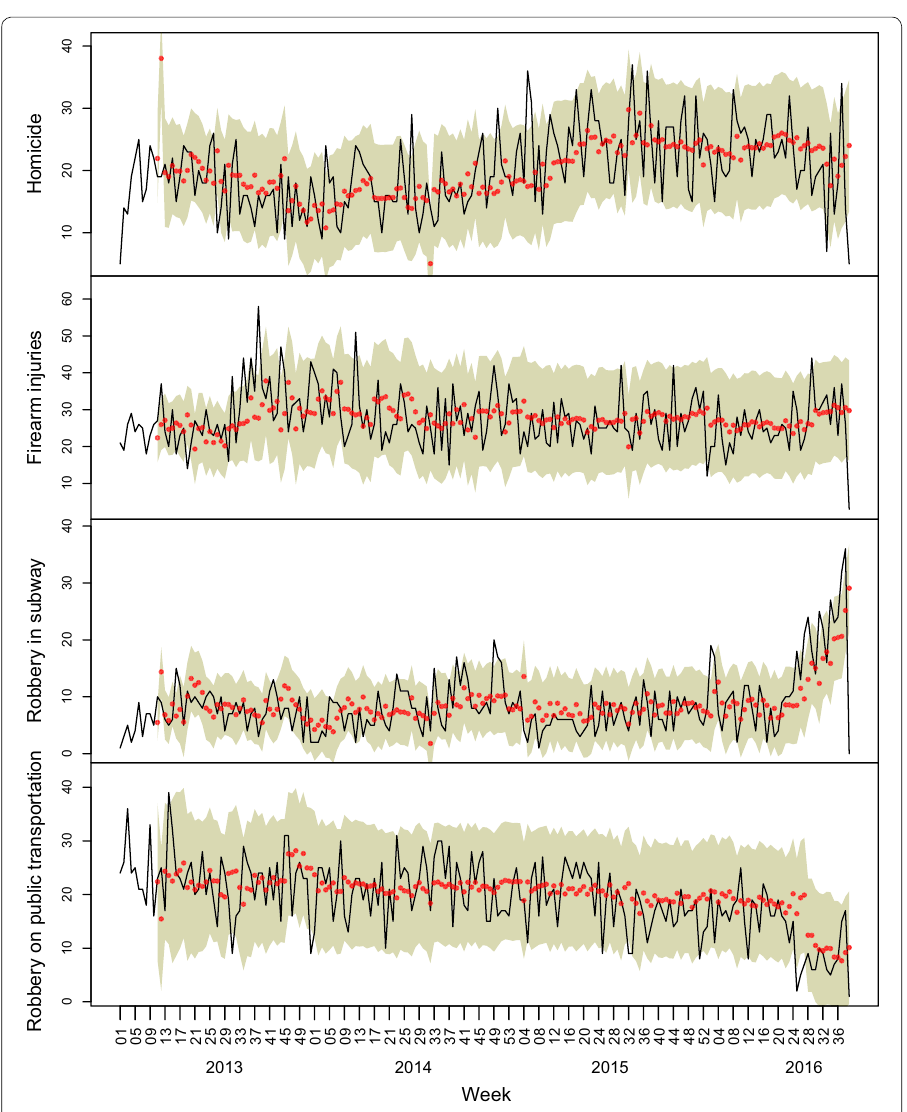
Fig. 15 One week adaptive forecasting for official crime dataset: part